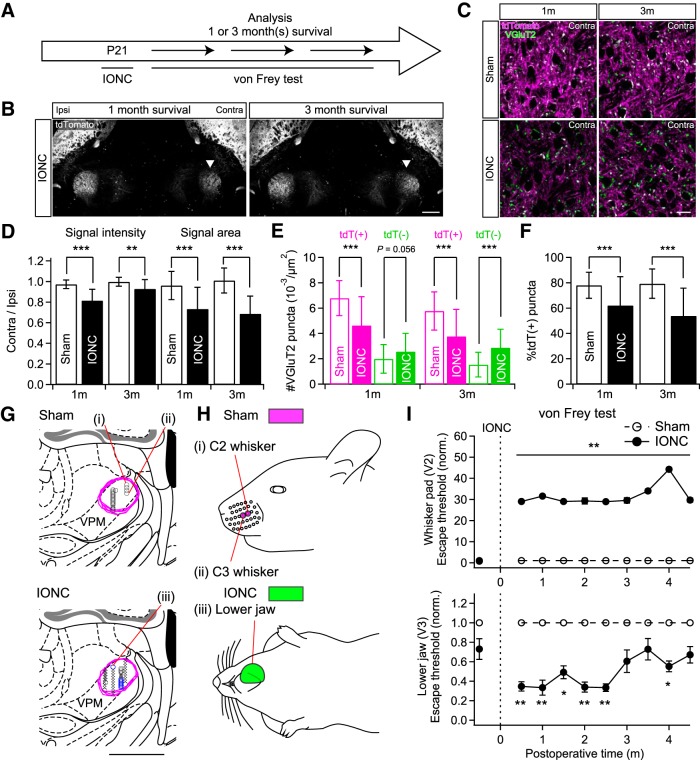
Long-lasting lemniscal fiber remodeling related to ectopic receptive fields of V2 VPM neurons and mechanical hypersensitivities on ectopic receptive fields. A, Experimental schedule. B, tdTomato signals in the V2 VPM of Krox20-Ai14 mice long after IONC. Arrowheads indicate the affected V2 VPM. Scale bar, 500 µm. C, VGluT2-immunostained sections of the V2 VPM. Significant increases of tdT-negative VGluT2 puncta after IONC. Scale bar, 20 µm. D, Ratios of contralateral to ipsilateral tdTomato signals of the V2 VPM in fluorescent intensity and area. Four mice (four images from each mouse) were examined for each group. E, Summary density of VGluT2 puncta in the contralateral V2 VPM. tdT(+) = tdTomato-positive VGluT2; tdT(-) = tdTomato-negative ones. F, IONC decreased proportion of tdT-positive VGluT2 puncta in the contralateral V2 VPM. Four mice (eight images from each mouse) were examined for each group in E and F. G, Recording sites located by electrical lesion made after receptive field recordings. All recordings made in the V2 VPM were analyzed and reconstructed on the brain atlas of Franklin and Paxinos (2008). Black circles = recording sites of maxillary receptive fields only; blue circles = recording sites of mandibular receptive fields; multiplication signs = nonresponsive sites. Magenta brackets indicate the V2 VPM regions. Roman numerals indicate the recording sites of representative recordings shown in H. Scale bar, 1 mm. H, Representative receptive fields of V2 VPM neurons. Each Roman numeral corresponds to the recording from the site indicated in G. Colored areas on the mouse cartoons indicate receptive fields at the recording sites. Magenta = sham; green = IONC. I, Face-escape thresholds assessed by von Frey filament stimuli on whisker pad and lower jaw before and 0.5–4.5 months after IONC operation on P21. Nerve regeneration was prevented for long-term evaluation (see Materials and Methods). Each value was normalized to that of the sham group. Nine mice were examined for each group. Values are represented as mean ± SD. Statistical significance was tested by two-way repeated measures ANOVA (main effect of IONC; D–F) and two-way repeated measures ANOVA and post hoc Tukey HSD test (I). *p < 0.05; **p < 0.01; ***p < 0.001; two-tailed.